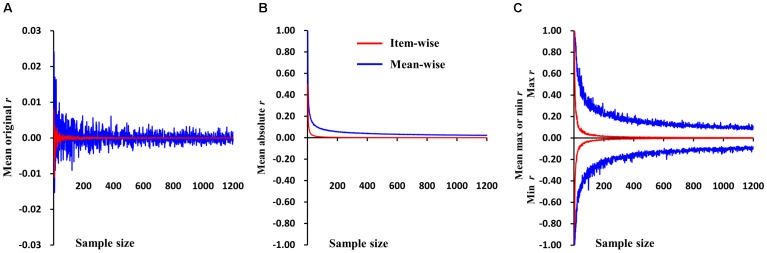
Simulations of item-wise and mean-wise interindividual brain-behavior correlations on same random data (i.e., without any signal). (A) Mean r-values for 1,000 samples of each size in item- and mean-wise correlation. (B) Item-wise correlation relative to mean-wise correlation with smaller absolute r-values for 1,000 samples at each size. (C) Item-wise correlation also results in smaller absolute maximum or minimum r-value.